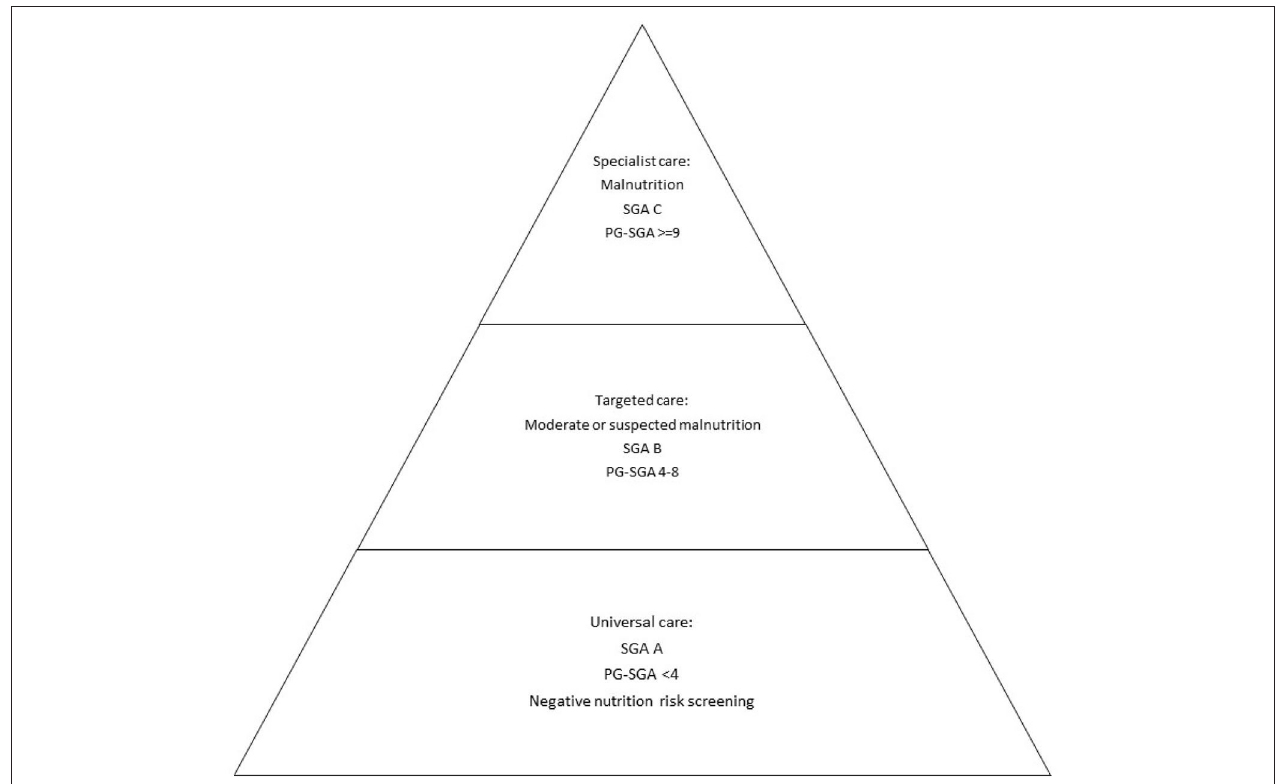
FIGURE 1 | Risk stratified care for nutrition